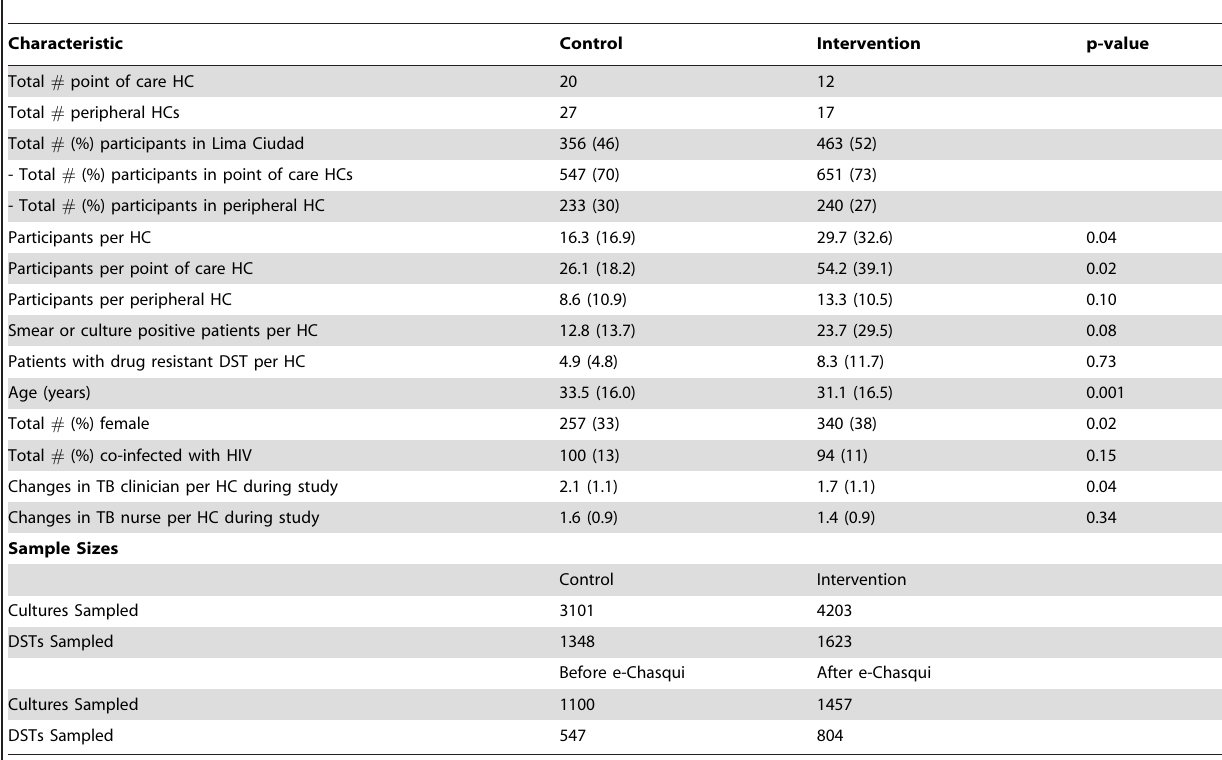
Table 2. Characteristics, outcome measures, and sample sizes for all study health centers (HCs) and participants.